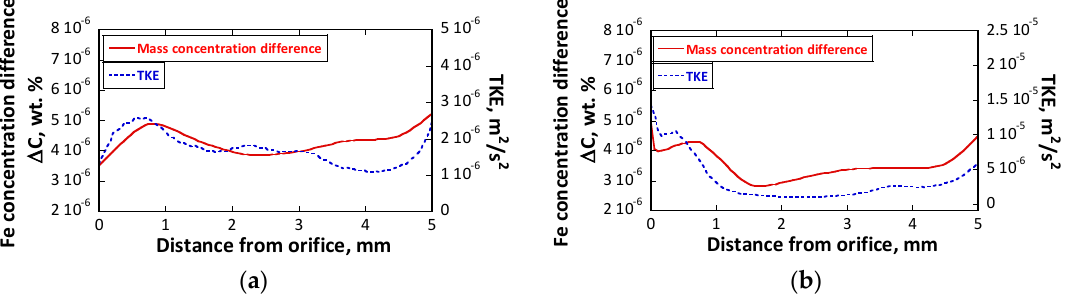
Figure 18. Comparison of mass concentration difference and TKE near the wall. ( a ) Inlet orifice; ( b ) Outlet orifice.